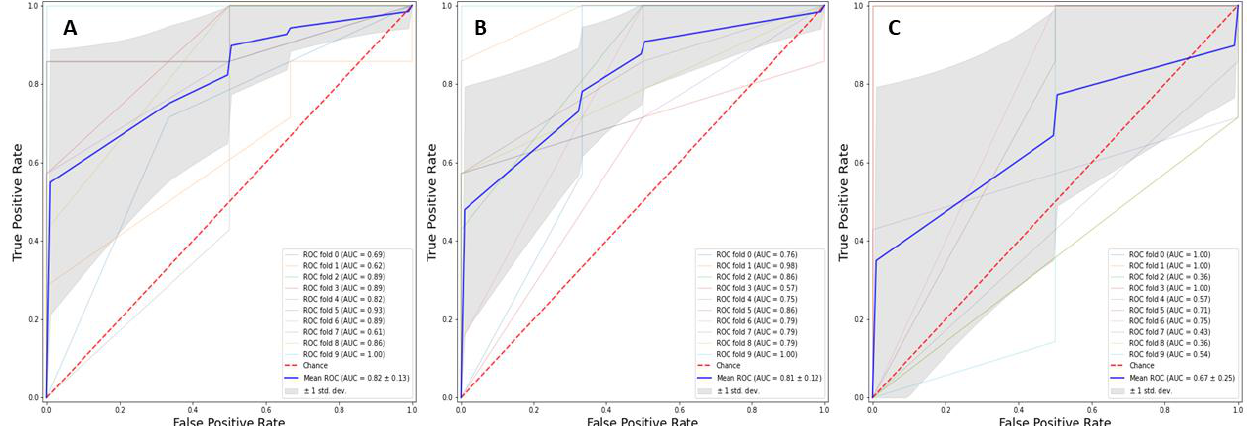
Figure 1. Receiver operating characteristics curve for Random Forest (box ( A )), Logistic Regression (box ( B )) and K-nearest neighbors (box ( C )) models.